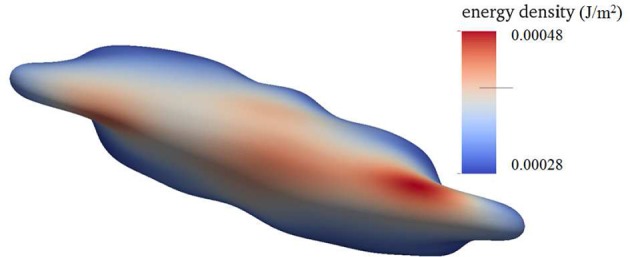
Contours of skeleton energy density, χ, in an oscillatory shear flow field. The shear rate was σ = 2,000s−1 at a frequency of 100 Hz. The cytosolic/medium viscosity ratio was equal to 1; the average shear stress applied to the cell was in the range τ¯~12Pa. Areas in red color are judged to be those with a high probability for vesiculation (see section 4.4).